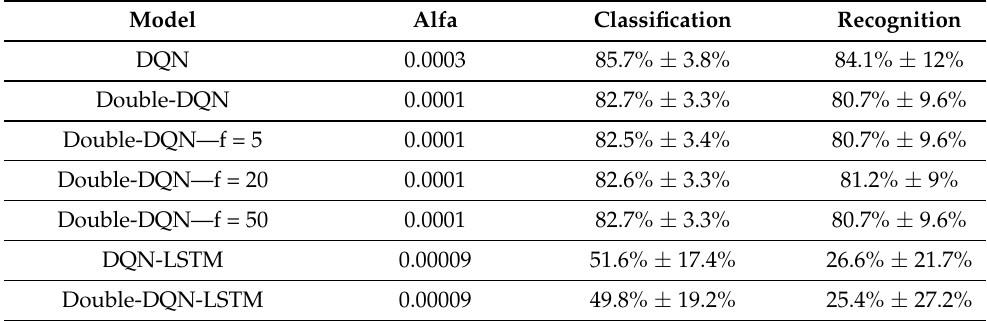
Table A1. Best user-specific HGR results for each model from the validation